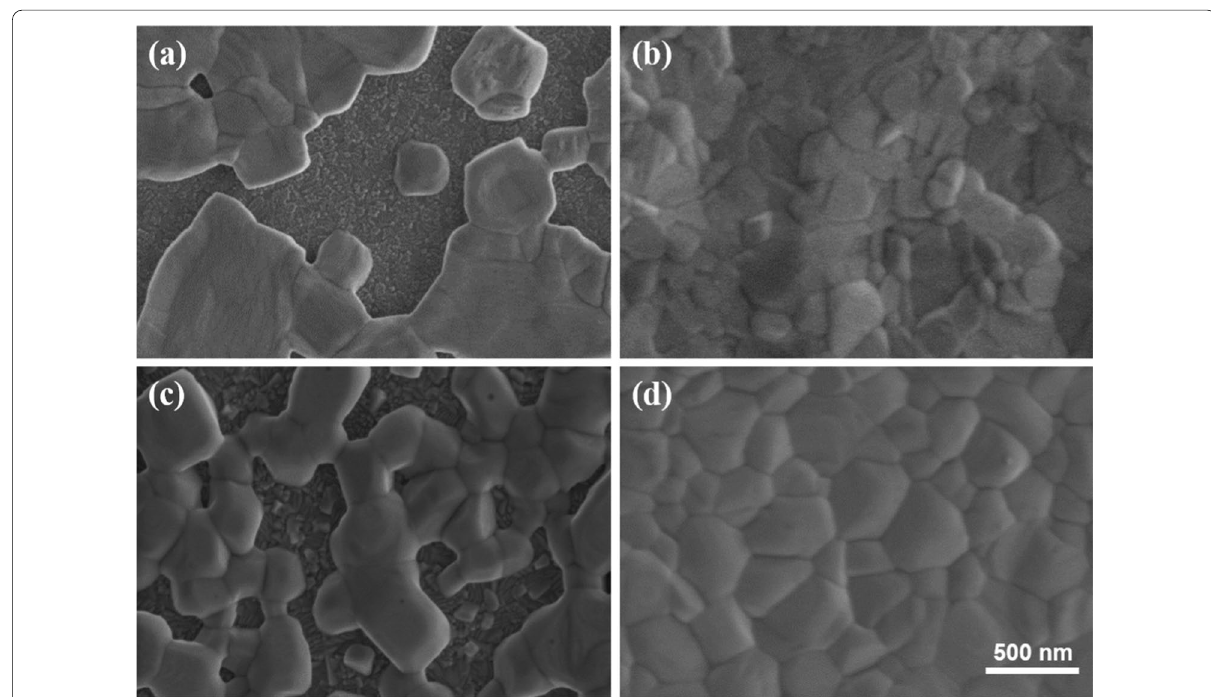
Fig. 1 Top-view SEM images of the all-inorganic perovskite films. CsPbI 2 Br film a without b with DE treatment; CsPbIBr 2 films c without d with DE